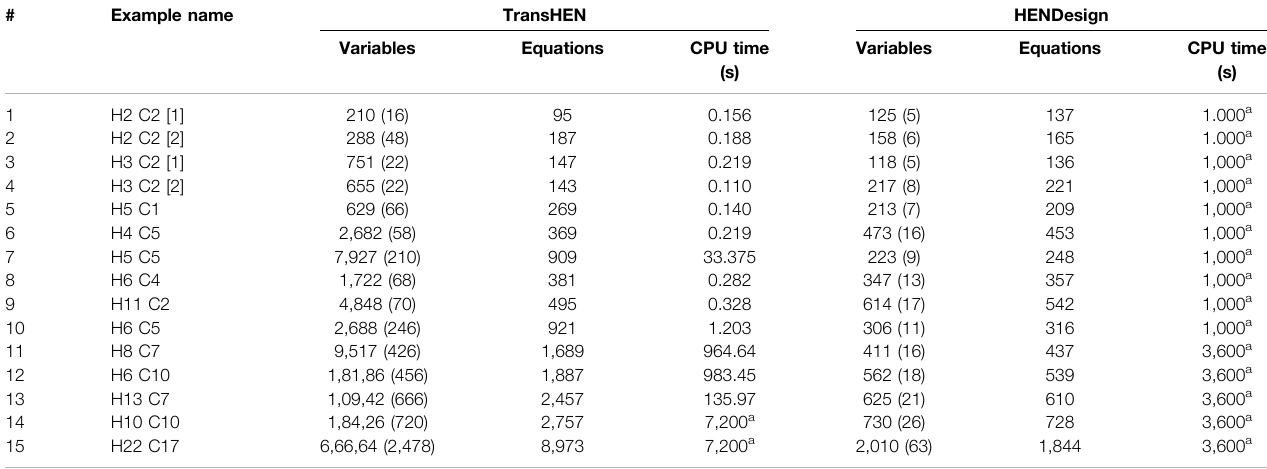
TABLE 2 | Some statistics for the models TransHEN and HENDesign in the test